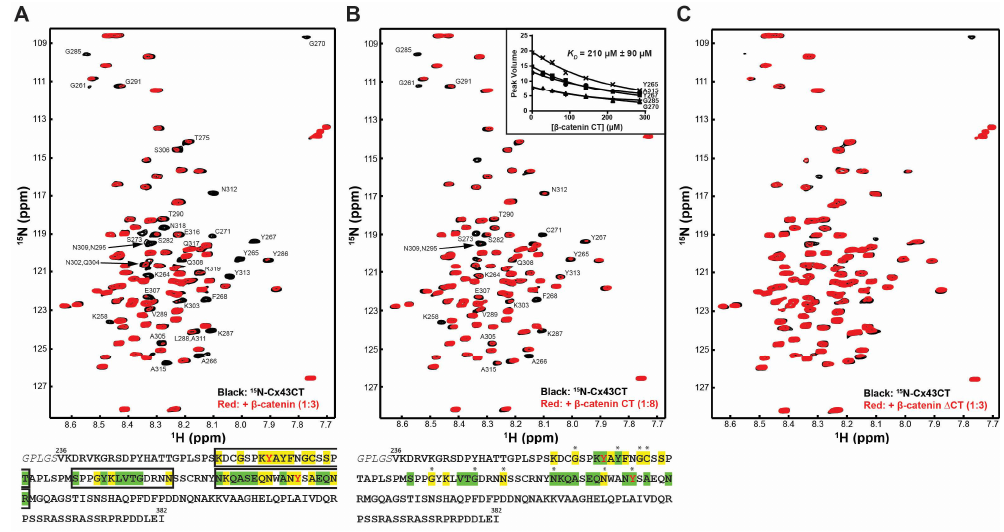
Figure 1. Nuclear magnetic resonance spectra showing the direct interaction between the Cx43CT and β-catenin. 15 N- heteronuclear single quantum coherence (HSQC) spectra of Cx43CT alone (black) and in the presence of ( A ) full-length β-catenin (red); ( B ) the β-catenin carboxyl-terminal (CT) domain (red); or ( C ) the β-catenin ΔCT domains (red). Molar ratio for each experiment is indicated in the figure. In panel B, provided is a subset of residues used to calculate the K D of the interaction by fitting their decrease in signal intensity according to β-catenin CT concentration. Below each 15 N-HSQC spectra is the Cx43CT amino acid sequence. Highlighted are the affected residues (yellow—peaks broadened beyond detection; green—peaks decreased in intensity). Black boxes delimitate the three areas of interaction with β-catenin. Asterisks denote that amino acids that were used to calculate the binding affinity for the β-catenin CT. Two of the residues phosphorylated by Src and affected by β-catenin are also highlighted (red letters).